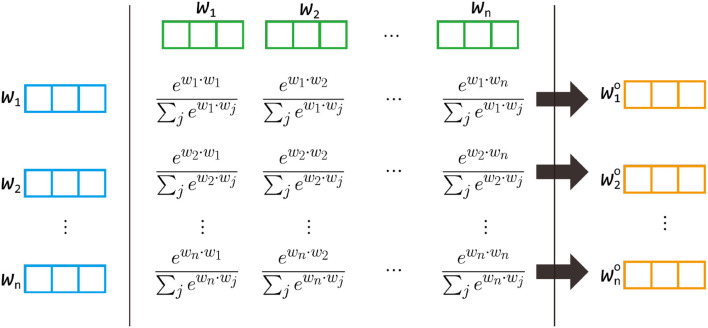
The idea of the multi-head self-attention model. wio will be reconstructed by {w1, w2…, wn} with the corresponding weights computed from wi and {w1, w2…, wn}. Notice that the formula of the weight is actually ewi·wj/d∑jewi·wj/d. The figure is used to illustrate the idea of weights so d is not listed.